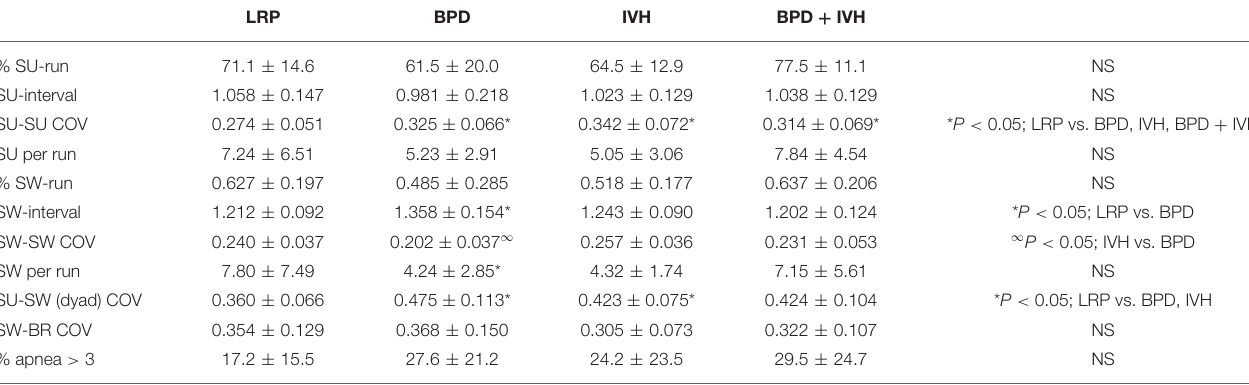
TABLE 2 | Feeding characteristics. LRP BPD IVH BPD +